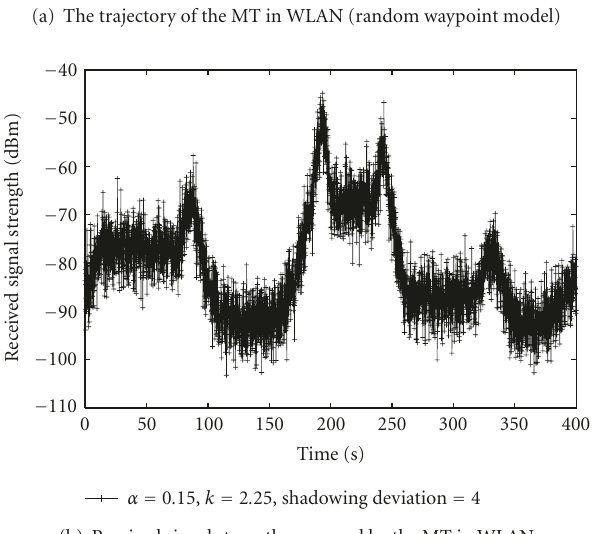
Figure 15: User motion trajectory and the RSS measured by the MT in WLAN.